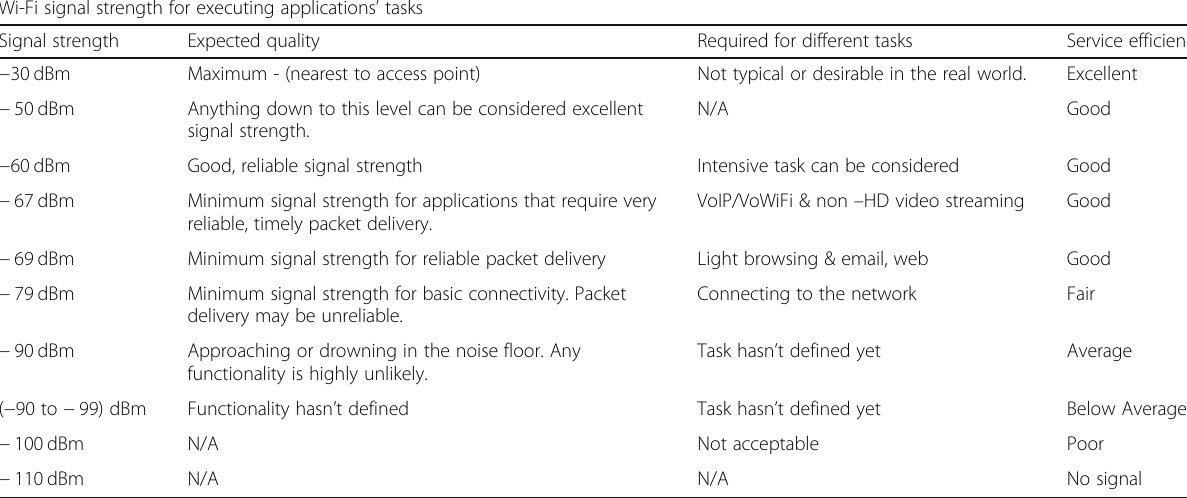
Table 3 Context vs. content tasks Wi-Fi signal strength for executing applications ’ tasks